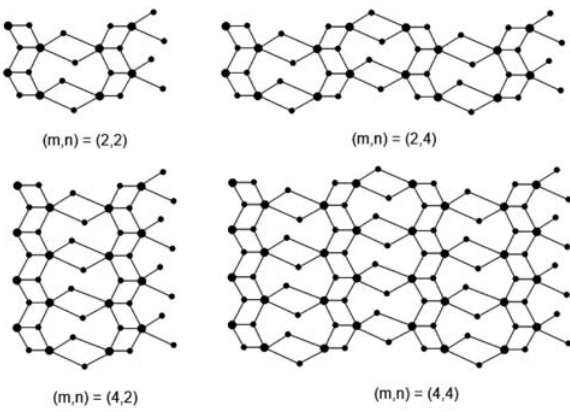
Figure 2. The graph of titania nanotubes TiO n = 2,4